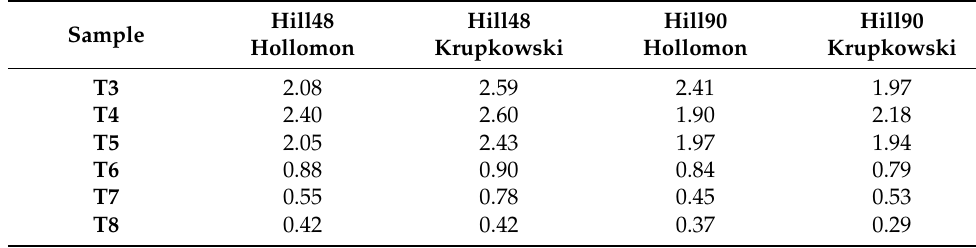
Table 6. The mean deviations (%) of predicted thickness values from the experimental thickness values using software with the implicit